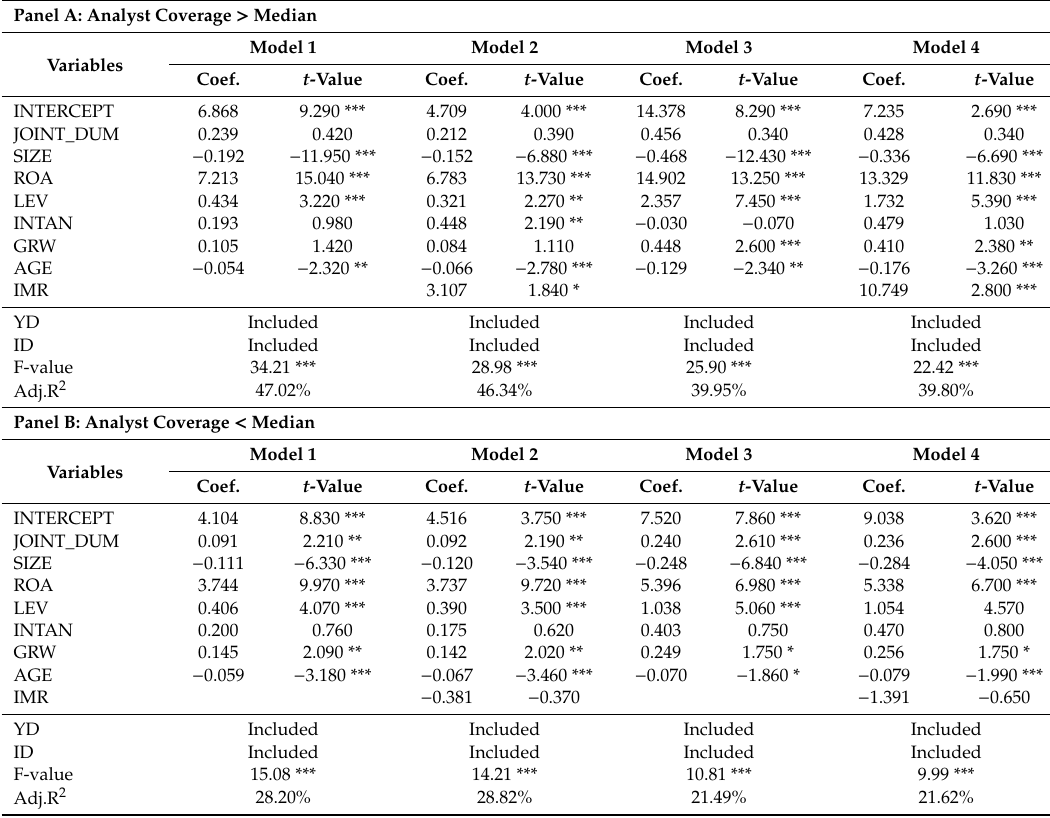
Table 11. Analysts’ cash flow forecast issuance and firm